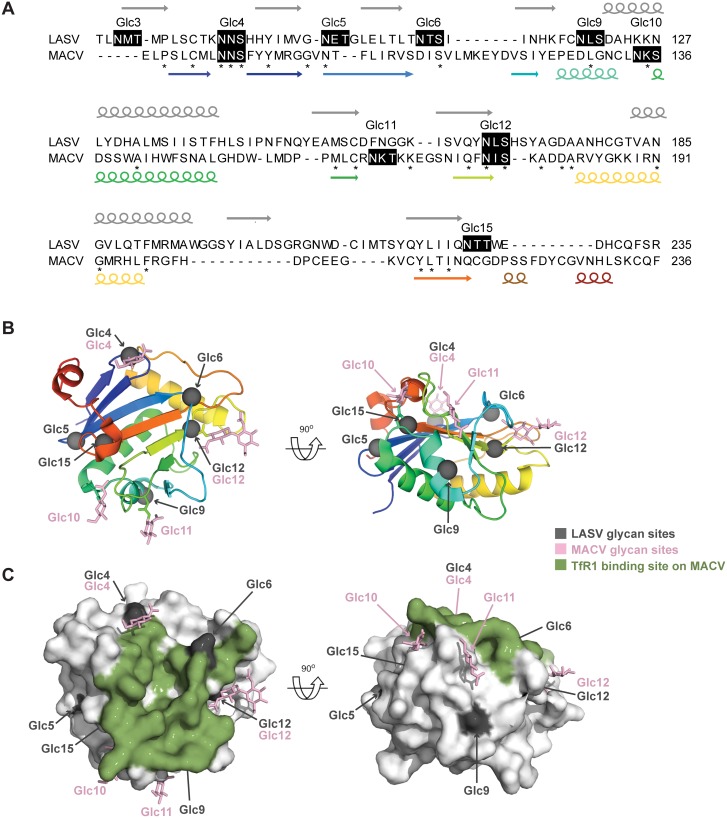
Mapping LASV GP-1 N-linked glycan sequons onto the structure of MACV GP-1.(A) The predicted secondary structure composition of LASV GP-1 (above the sequence) was compared to the secondary structure observed in the crystal structure of MACV GP-1 (below the sequence, [48]). Arrows represent beta-sheets and spirals represent helices, the rainbow code corresponds to panel B. Stars indicate identical residues. The number and position of predicted N-linked glycans are indicated above black shaded sequons. The alignment and annotations were extracted from the arenavirus GP-1 sequences alignment presented in S1 Fig. (B) Cartoon diagram of MACV GP-1 colored as a rainbow ramped from blue (N-terminus) to red (C-terminus). Sites of N-linked glycosylation observed in the MACV GP-1 crystal structure are annotated and shown as pink sticks. The locations of putative N-linked glycosylation sequons from LASV GP-1 were mapped by sequence alignment (S1 Fig) and are shown as grey spheres. (C) Surface of MACV GP-1 shown in van der Waals surface representation. Residues on MACV GP-1 which form contacts with human TfR1 are colored green. N-linked glycan sites and sequons are colored as in panel B.